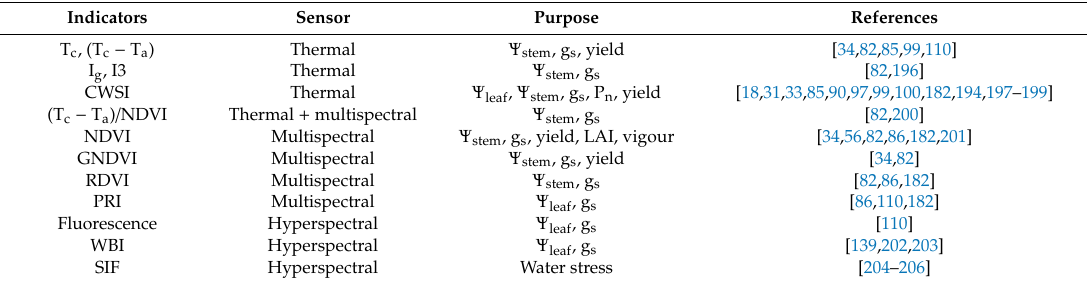
Table 2. Commonly used vegetation and thermal indices to study the water status of horticultural crops.